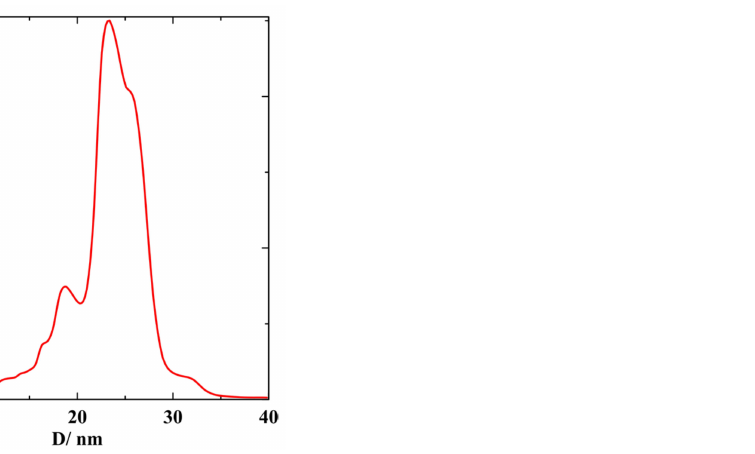
Figure 1. The normalized pore volume distribution dV / dD ( D is the pore diameter) in the porous glass template.